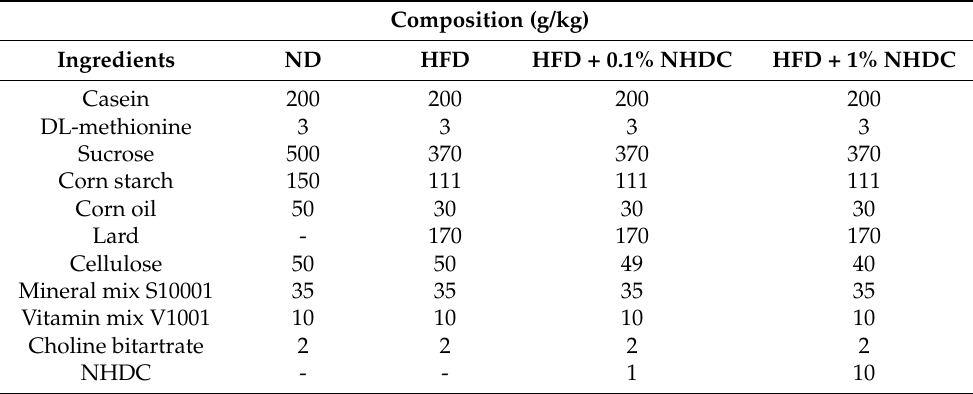
Table 1. Experimental diet